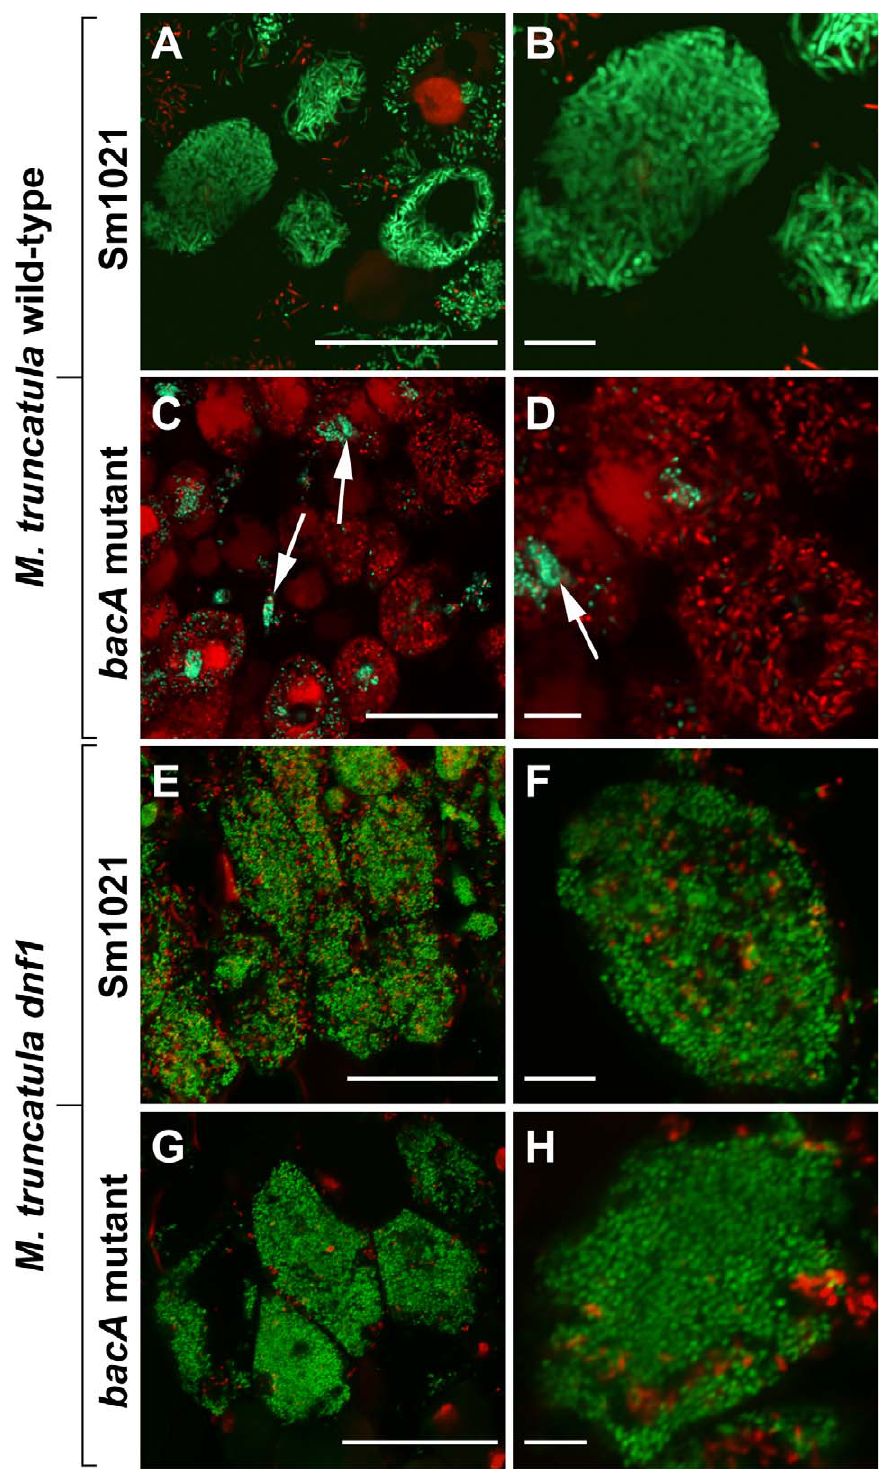
Figure 3. The S.meliloti BacA-deficient mutant undergoes rapid death in symbiosomes. Confocal microscopy of infected cells in nodules of wild-type M. truncatula (A–D) or the M. truncatula dnf1 mutant (E–H). Nodules were infected by either the S. meliloti Sm1021 wild-type strain (A,B,E,F) or the BacA-deficient mutant (C,D,G,H). Nodules were stained with a mixture of SYTO9 (green signal) and PI (red signal). Live bacterial cells are stained by SYTO9 and dead bacteria are stained by PI. Arrows in (C,D) indicate rhizobia in infection threads. Scale bars are 50 m m (A,C,E,G) or 10 m m (B,D,F,H).